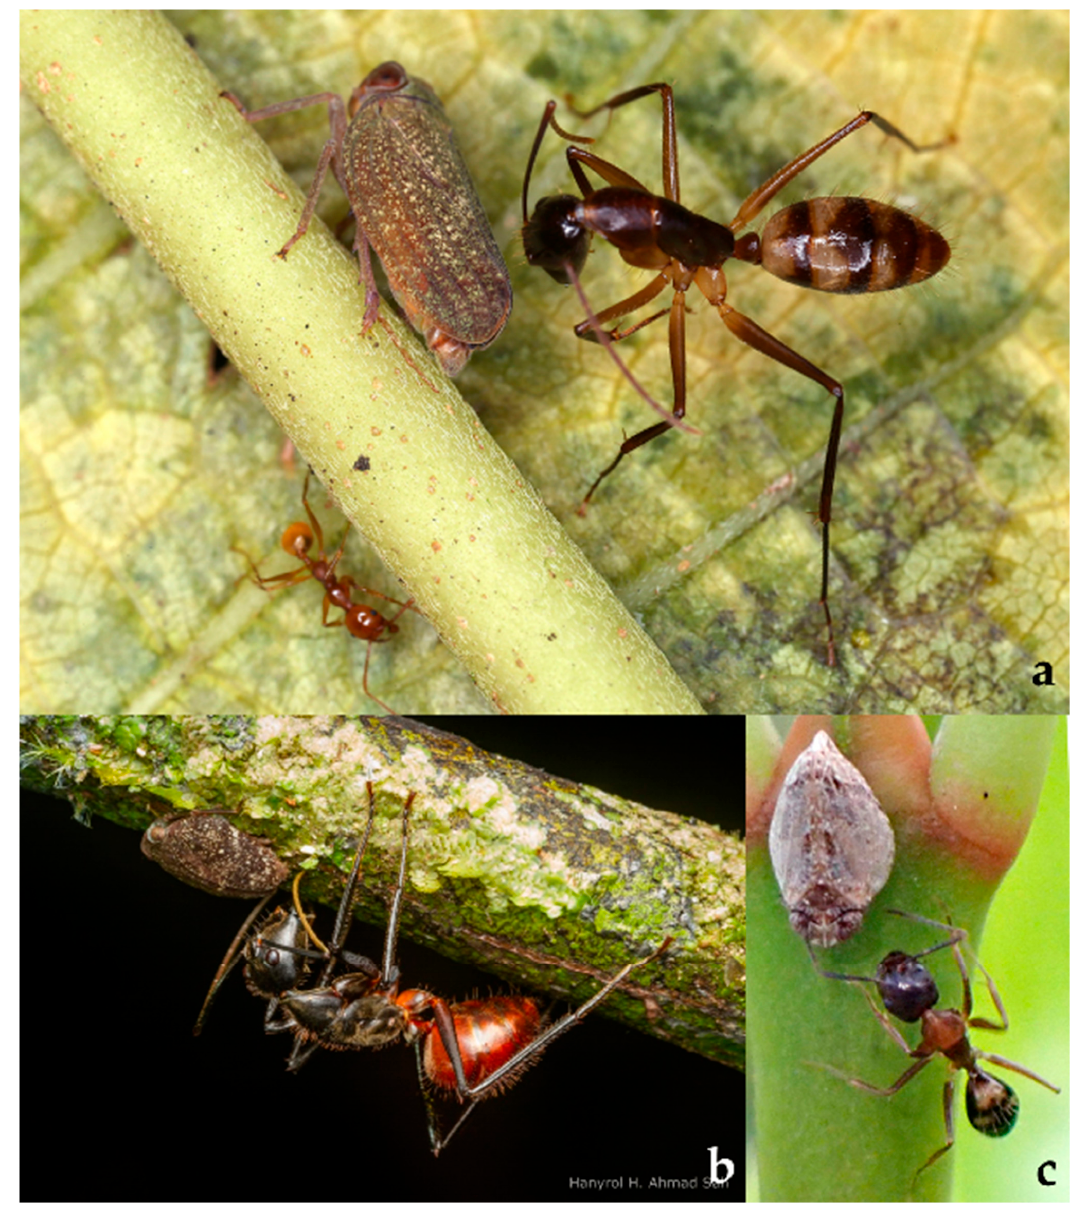
Figure 22. Issidae: ( a ) Thioniini indet. tended by Formicidae: Formicinae: Camponotus sp., Costa Rica: La Leona Eco Lodge, 8°26 ′ 54.17 ″ N; 83°29 ′ 13.54 ″ W, 16.02.2018, adult on tree trunk, obs. G. Kunz; ( b ) Issidae indet. tended by Formicidae: Formicinae: Dinomyrmex gigas (Latreille, 1802), Brunei: Kg Menengah, 4°26 ′ 53.3 ″ N 115°12 ′ 45.5 ″ E, 11.08.2021, adult, obs. H. Ahmad Sah; ( c ) Issidae indet. tended by Formicidae indet., Malaysia: Kuala Lumpur, Perdana Botanical Garden, 3°08 ′ 20.4 ″ N 101°41 ′ 12.7 ″ E, 27.10.2019, adult, obs. T. Maul.